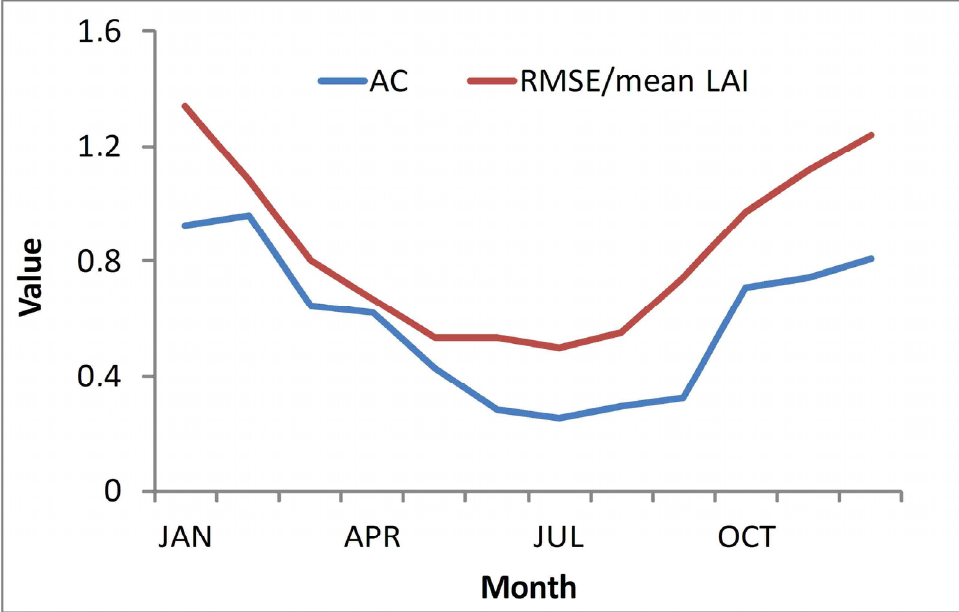
Figure 7. Temporal profiles of the agreement coefficient (AC) and RMSE/mean LAI between LAI3g and LAI GGRS for 2008 over